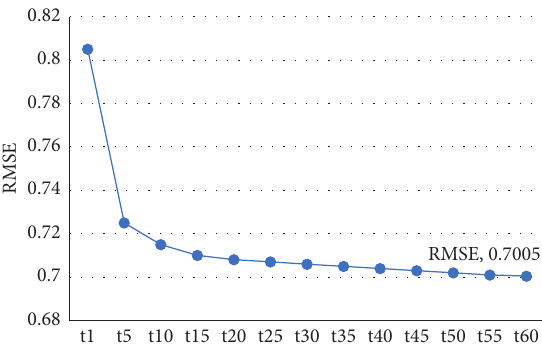
Figure 16: Performance of the number of iterations on Douban Book.